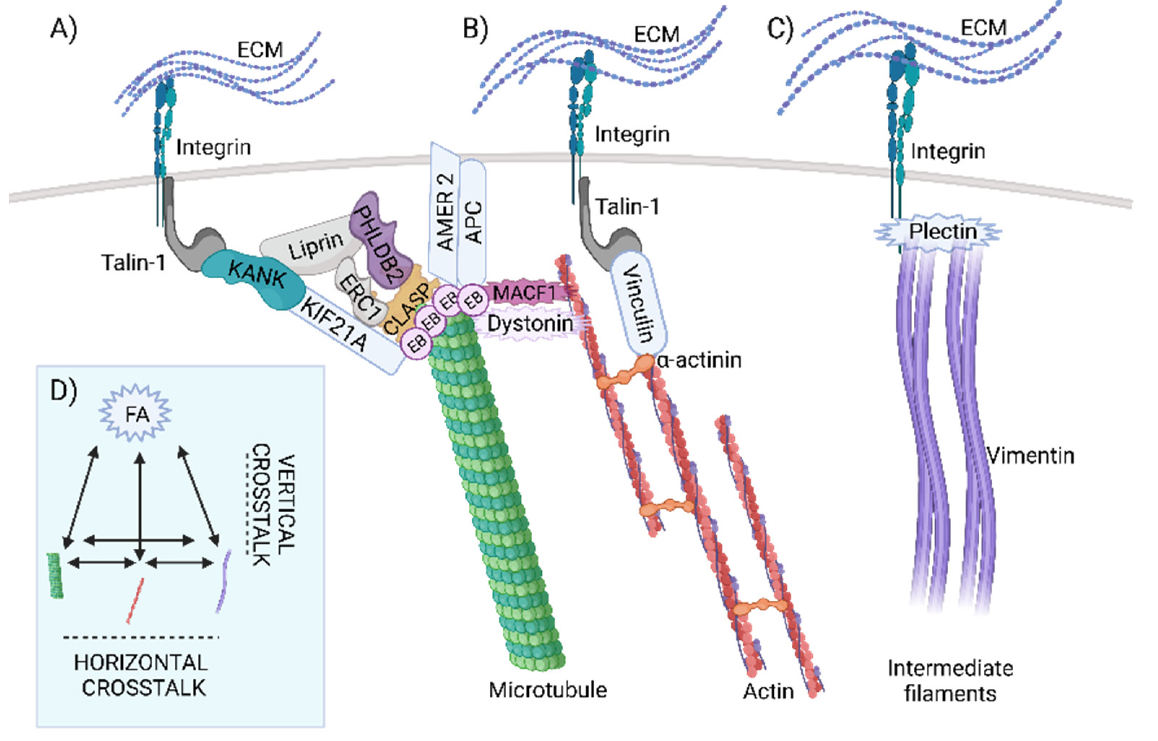
Figure 2. Schematic representation of vertical and horizontal crosstalk. ( A ) After binding to ECM proteins, the signal is transduced to focal adhesions via integrins. Proteins of the cortical microtubule stabilization complex (liprins, ERC1, PHLDB2, CLASPs, AMER2, and APC) play an important role in force transmission to microtubules, while direct binding of KANK to talin-1 and KIF21A contributes to microtubule recruitment to the outer rim of focal adhesions. ( B ) Force transmission to actin filaments is facilitated by the binding of talin-1 to cytoplasmic integrin tails that recruit mediators such as vinculin and actinin alpha and help to transduce the signal to actin filaments. ( C ) ECM-integrin-mediated force transmission to intermediate filaments is facilitated by binding of the β 4-subunit and plectin, whereas depletion of vimentin blocks β 4-enhanced invasion. In addition, binding of plectin to the β 4 subunit is responsible for recruitment to focal adhesions and cell spreading. ( D ) Simplified scheme of vertical and horizontal crosstalk.